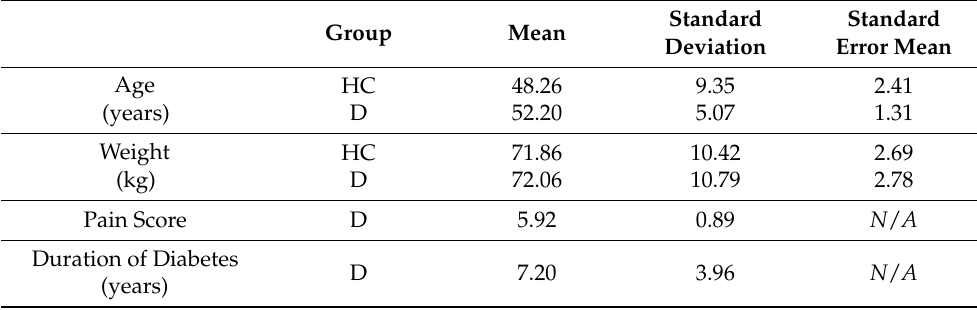
Table 1. Demographic data of the volunteers (group HC and D both having N = 25 volunteers).